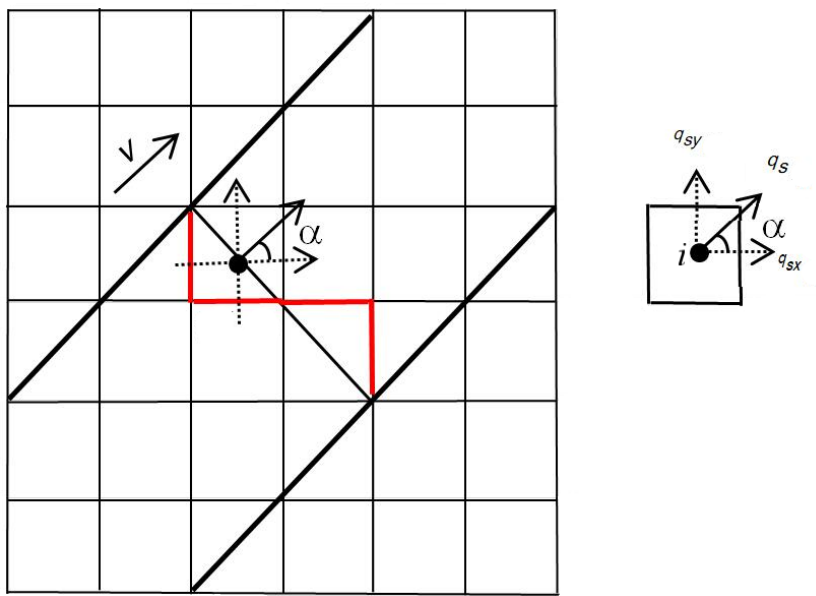
Figure 2. Calculating fluxes through a sluice gate using the flux term coupling approach.